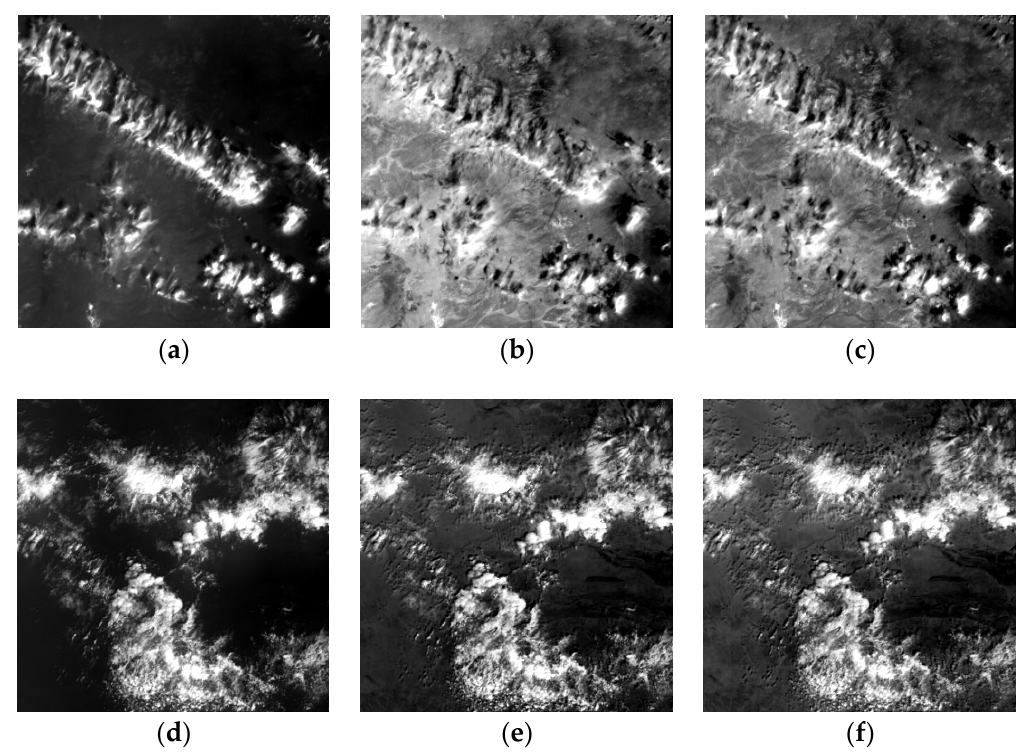
Figure 2. CAPI images over Australia on 29 March 2017. ( a – c ): Images of semi-vegetated areas in southern Australia; ( d – f ): Images of desert areas in central Australia. ( a , d ): Images of 0.38 μ m band; ( b , e ): Images of 0.67 μ m band; ( c , f ): Images of 0.87 μ m band.